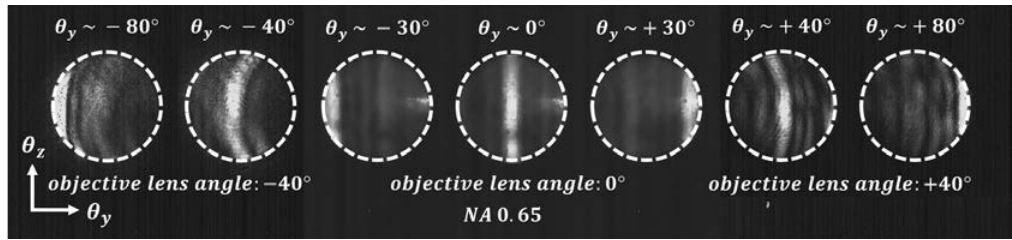
Figure 5. Far-field patterns measured from the 1 × 16 OPA.